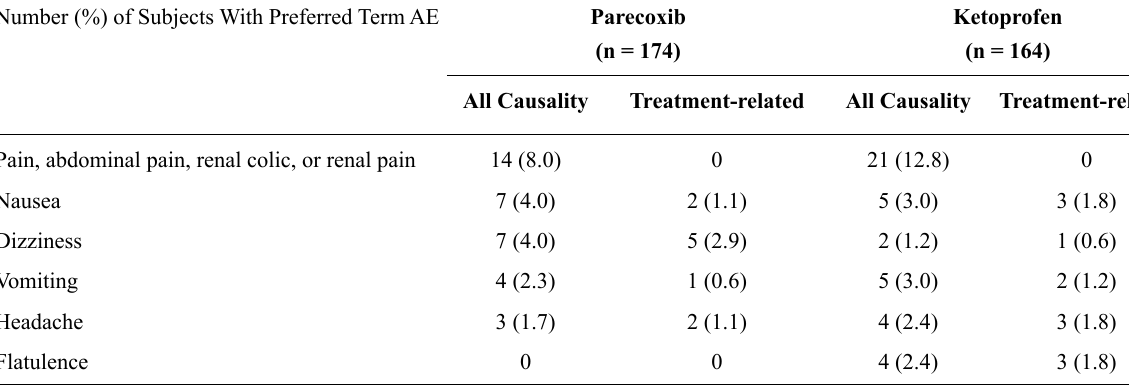
Table 3 - Most frequently reported adverse events by preferred term. Number (%) of Subjects With Preferred Term